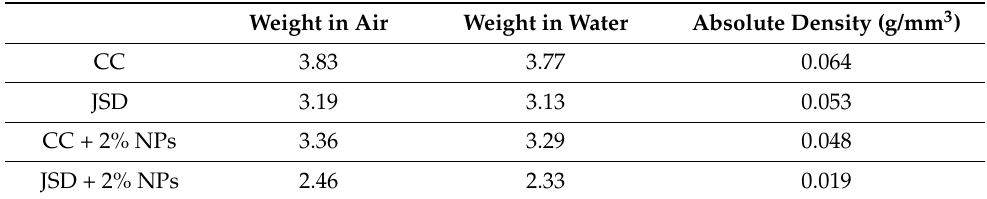
Table 2. Absolute density of the prepared foamed samples.